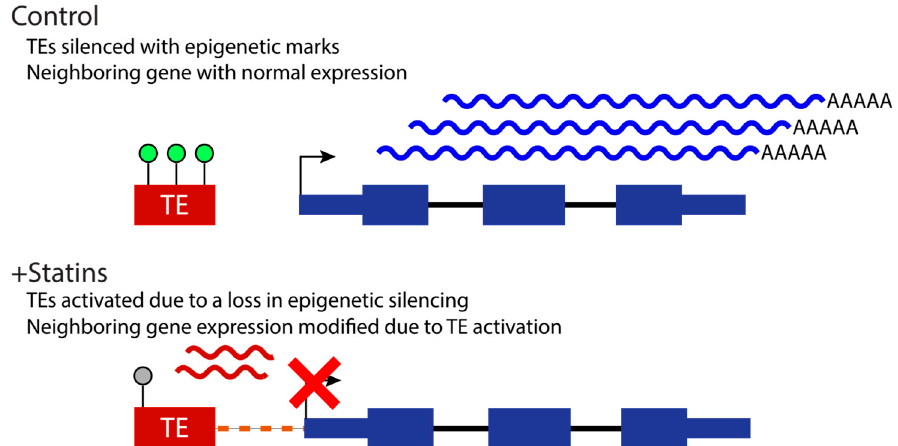
Figure 4. Proposed mechanism of TE activation upon statin treatment. Under normal conditions, TEs (red rectangle, “TE”) are epigenetically silenced (green circles above TE), and the expression of neighboring genes is uninterrupted (blue curly lines). Stress induced by statin treatment results in a loss of epigenetic silencing (grey circle above TE), which causes the TE to become activated (red curly lines), negatively influencing the expression of the neighboring gene.